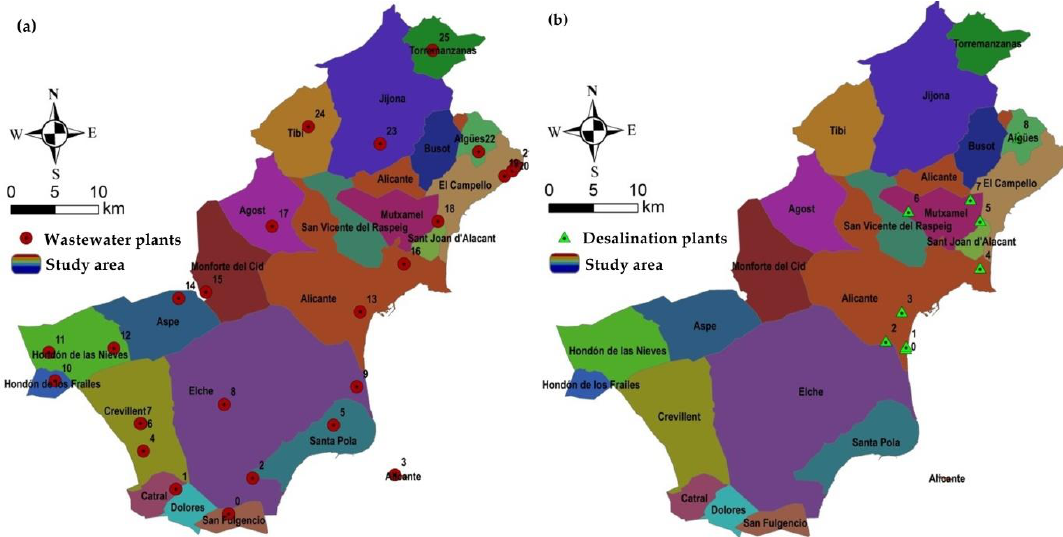
Figure 4. Location of non-conventional treatment plants in the study area: ( a ) Wastewater plants; ( b ) Desalination plants. Source: elaborated with information from [20].